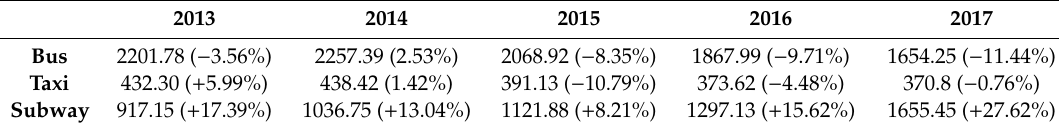
Table 1. Passenger flow volume and annual change for major modes of